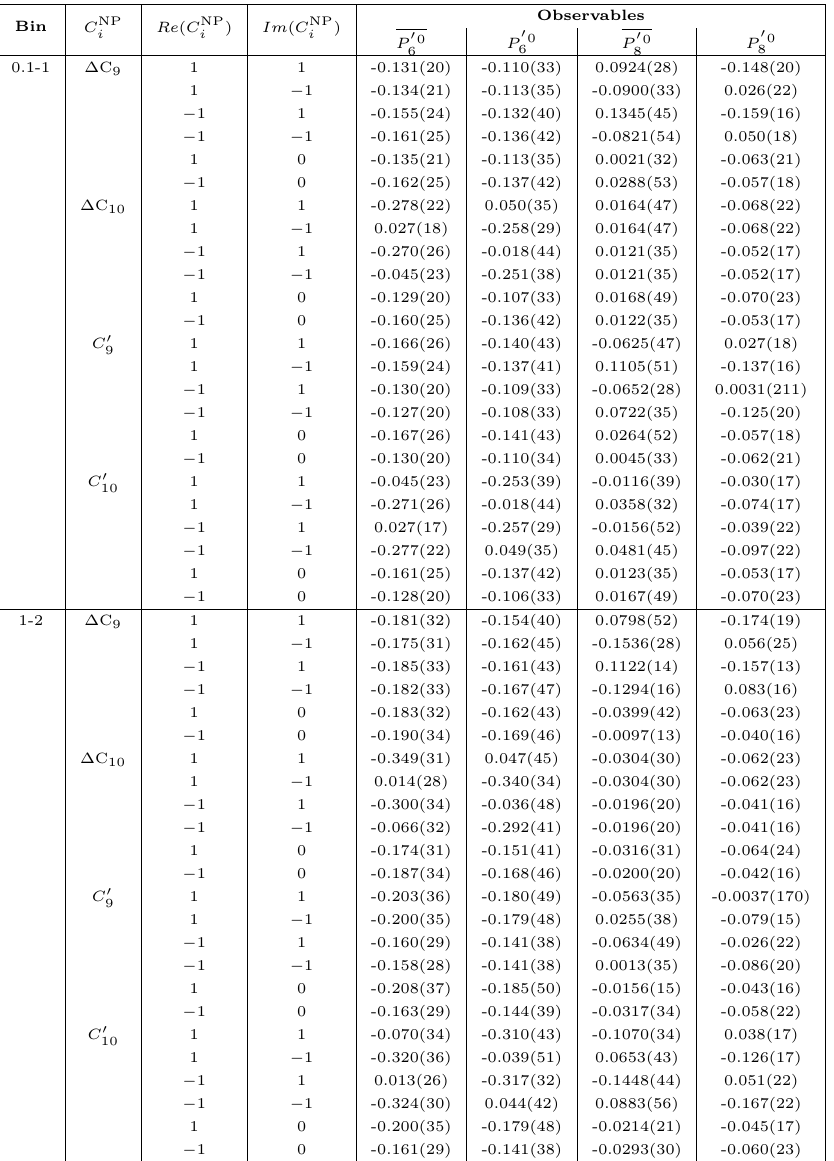
Table 34 . The dependence of some of the optimized observables corresponding to tagged and B 0 → ρ 0 ll on the real and imaginary parts of the NP WC’s ∆ C bins 0 . 1 − 1 and 1 − 2 GeV 2 for a few benchmark values of the real and imaginary parts of the corresponding